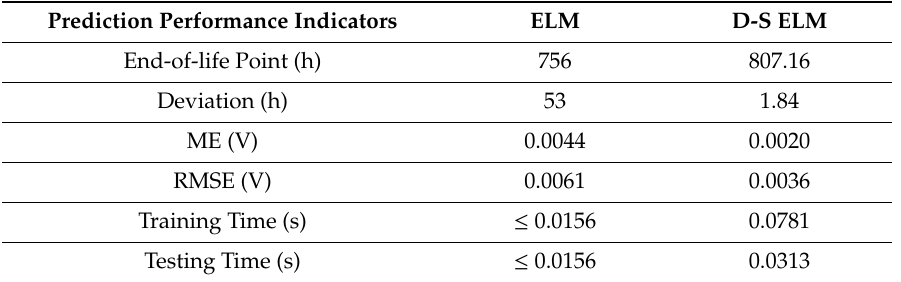
Table 2. Comparison of prediction results of two algorithms (the size of training sample is set as 10). Prediction Performance Indicators